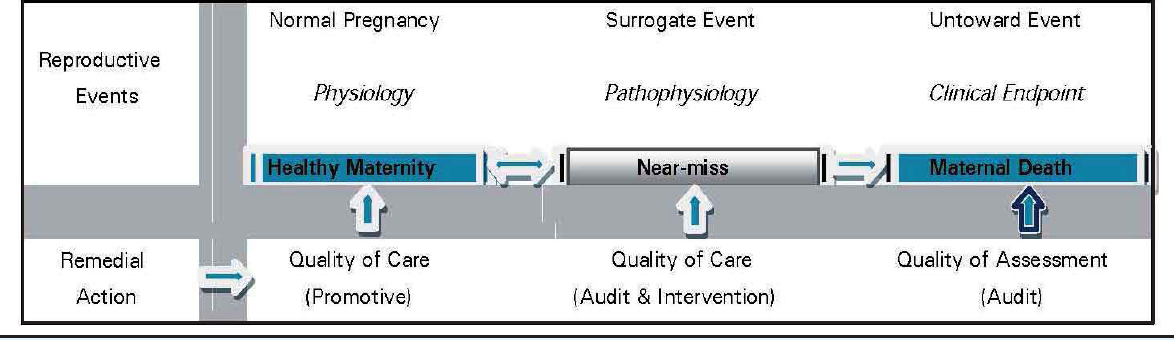
Figure 1. Conceptual